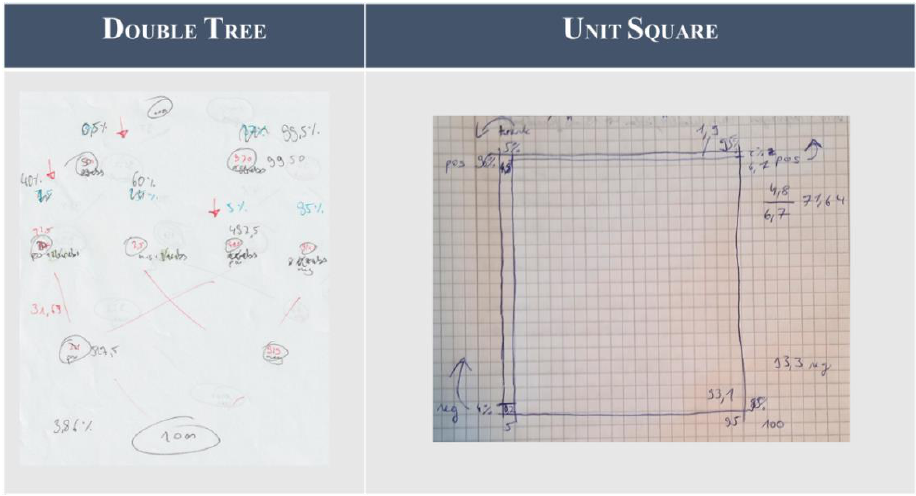
Figure 12. The students ’ notes while working on the learning task on the aspect of covariation.